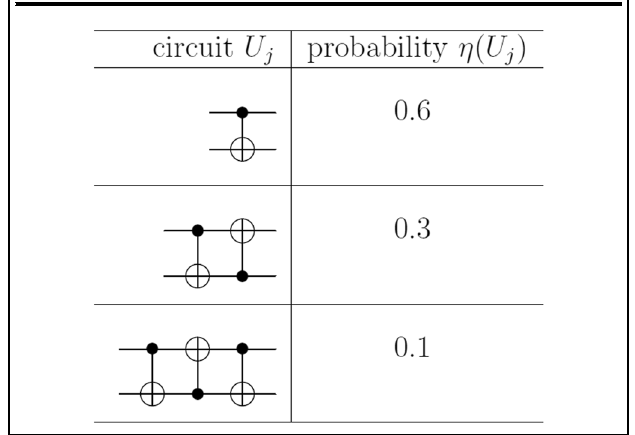
Table 3. Optimal two-qubit Clifford 2-design with the average cost 1.5. This coincides with the average cost of the full Clifford group C 2 .